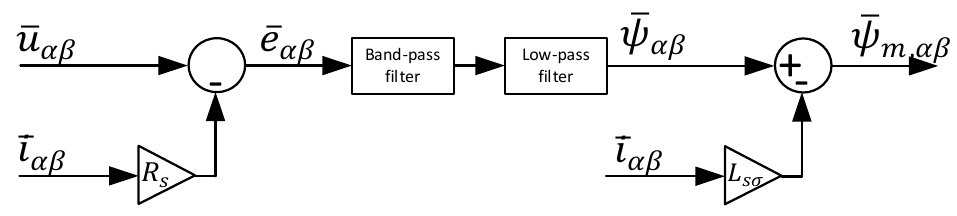
Figure 5. Block diagram of the flux estimator based on the voltage model of the machine.